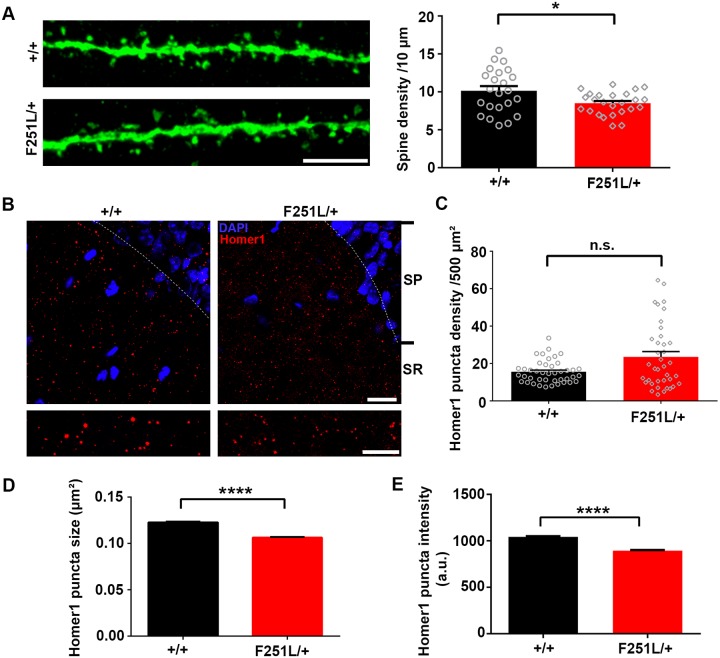
Heterozygous TBC1D24F251L/+ knock-in mice exhibit aberrant Homer1 puncta and reduction of dendritic spine density in the hippocampus in vivo.(A) Representative images of hippocampal CA1 secondary apical dendrites after injection of AAV carrying YFP into the hippocampi of wild-type and heterozygous TBC1D24F251L/+ knock-in mice (12 weeks old). Heterozygous TBC1D24F251L/+ knock-in mice displayed reduced density of dendritic spines in CA1 of hippocampus (23–25 dendrites from 4 mice were quantified for each genotype; mean+SEM; *p<0.05; upaired Student’s t-test). (B) Immunohistochemistry of hippocampal slices from wild-type and F251L heterozygous knock-in mice (6 weeks old) with Homer1 staining. Representative images of Homer1 puncta in the stratum radiatum (SR) of hippocampus CA1 region. SP = stratum pyramidae. (C-E) The number of Homer1 puncta was not significantly changed (p = 0.1989), while the size and intensity of Homer puncta were significantly reduced in the heterozygous TBC1D24F251L/+ knock-in mice [38–42 images from 4 mice were quantified for each genotype; mean+SEM; Mann-Whitney test in (C); 25605–34877 puncta were analyzed for each condition; mean+SEM ****p<0.0001;Mann-Whitney test in (D, E)]. Scale bars: top, 20 μm; bottom, 10 μm.